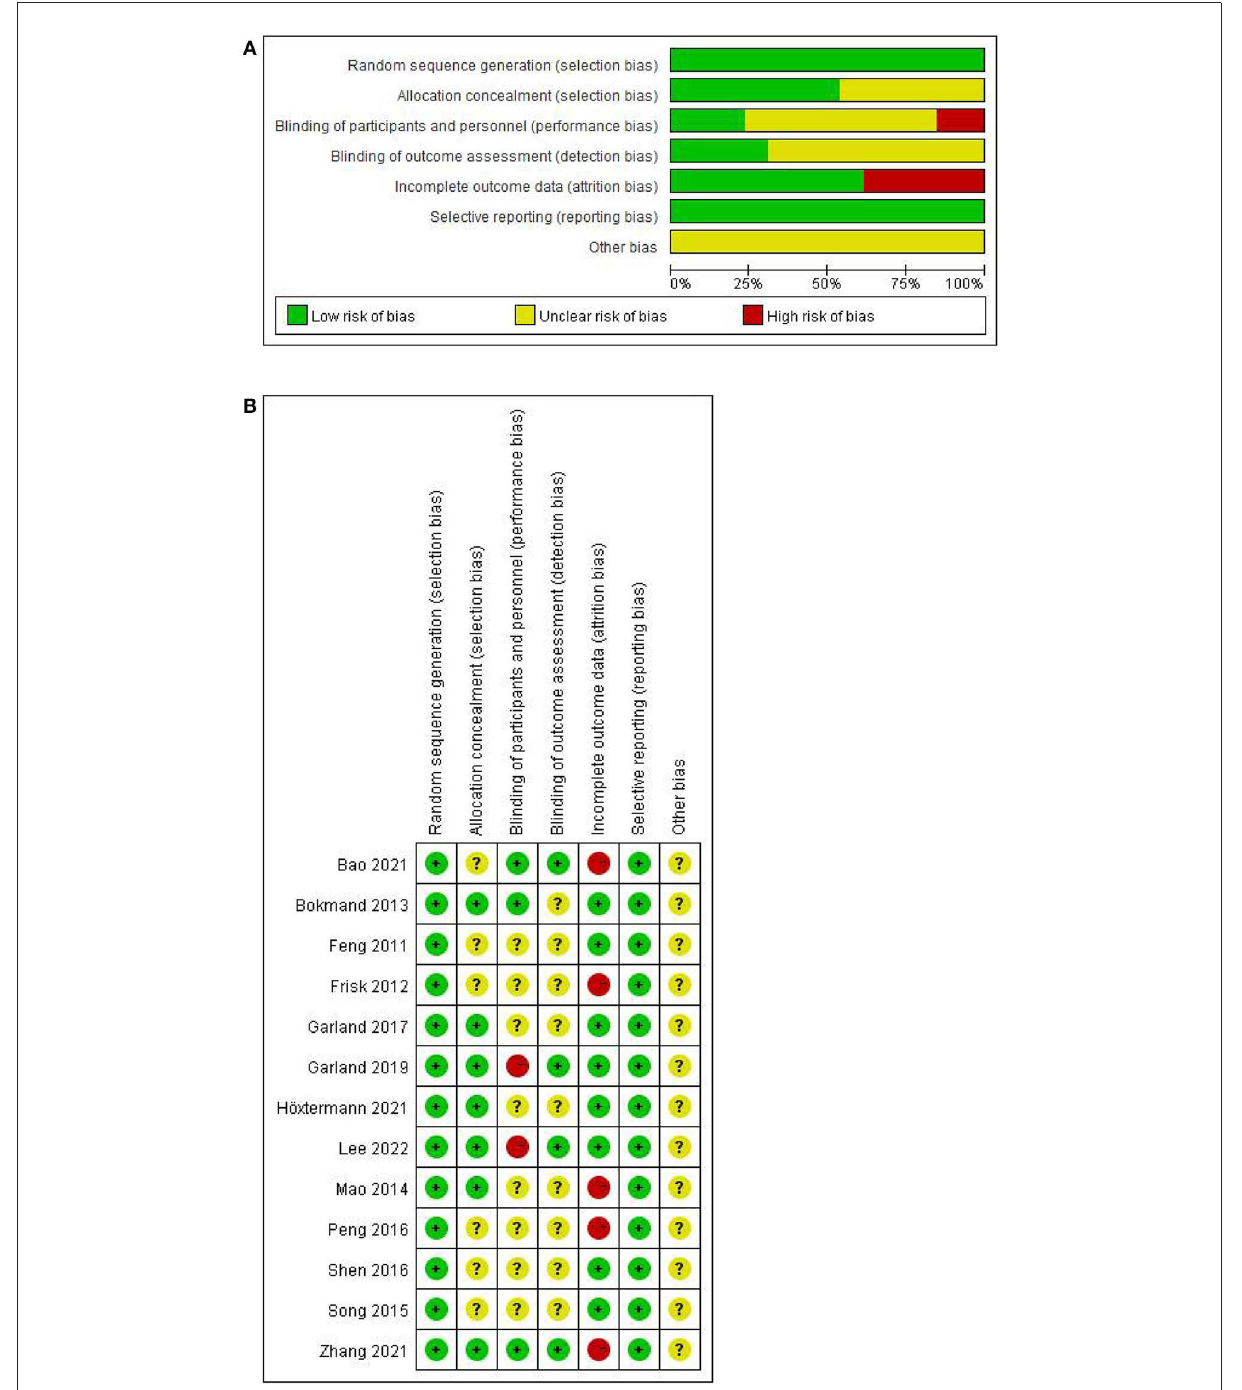
FIGURE2 Risk of bias of included trials. (A) Assessment of risk of bias presented as percentages across all included studies. (B) Risk of bias summary for each included